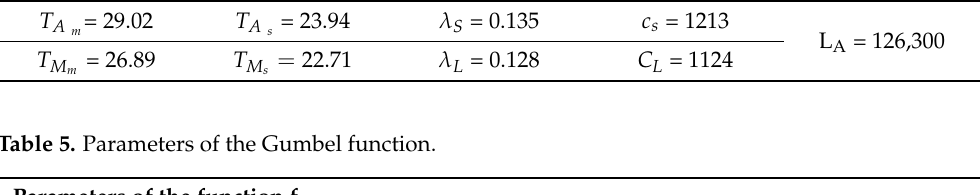
Table 4. Thermal characteristics of ETMV 8.